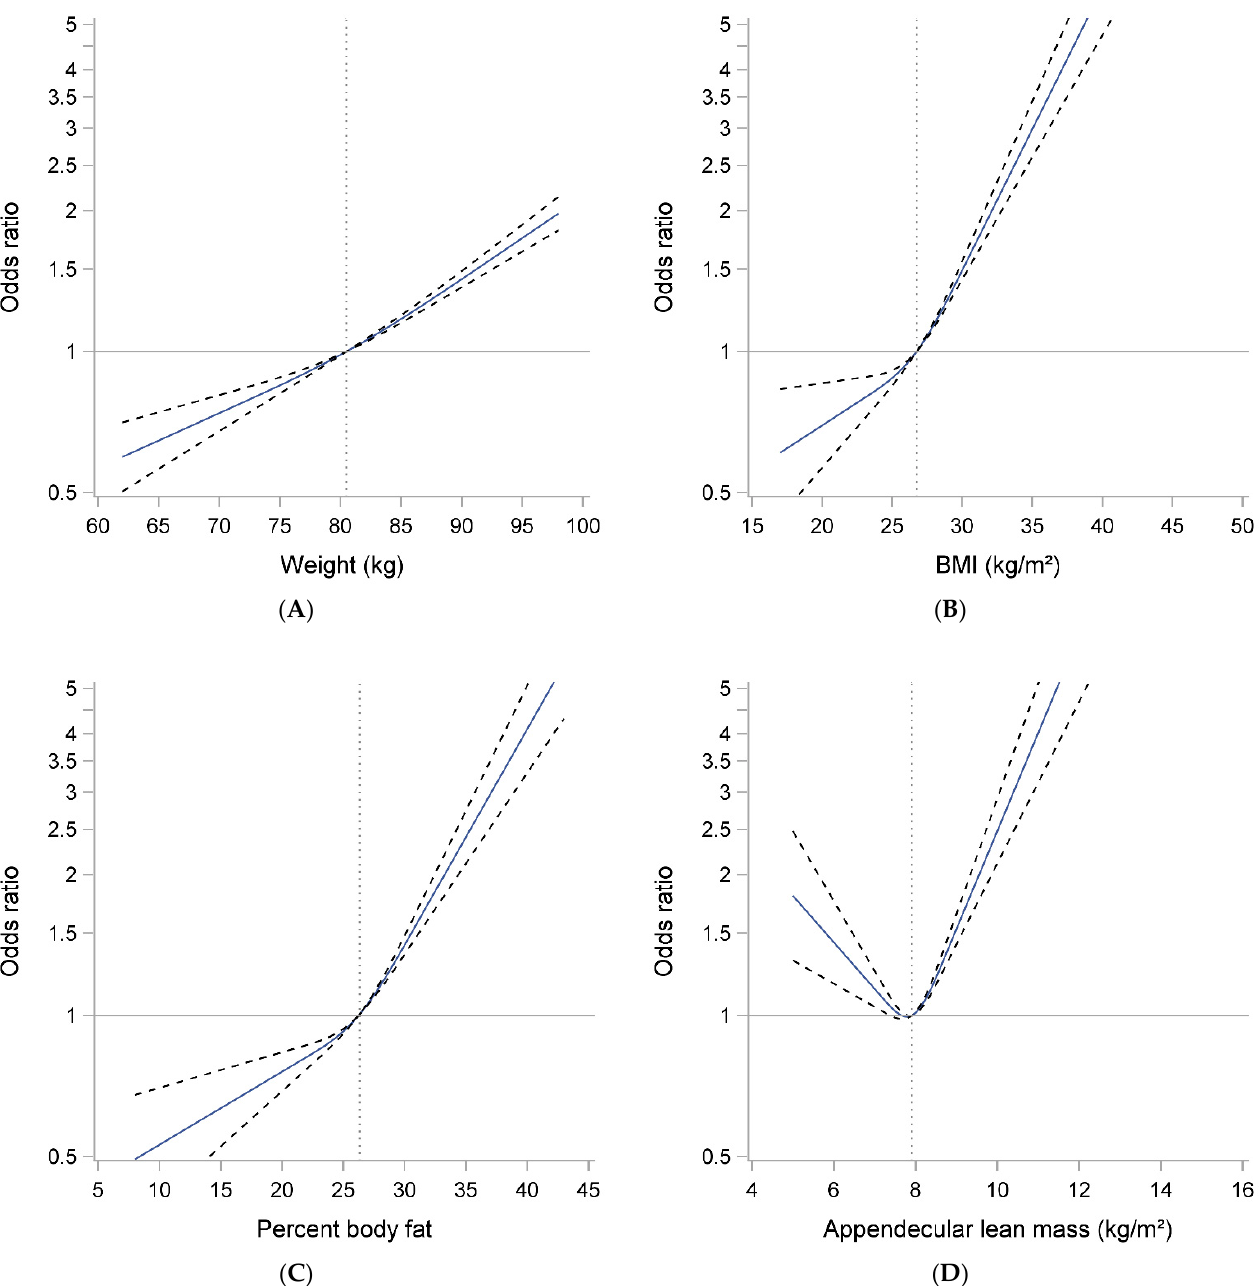
Figure 2. Spline plots of the association between body size and composition (( A ) Weight, ( B ) BMI, ( C ) Percent Body Fat and ( D ) Appendicular lean mass) with mobility limitation in older men. Models are adjusted for age, clinical site, race, total energy intake, smoking and comorbidity. Weight and percent fat models adjusted additionally for height.